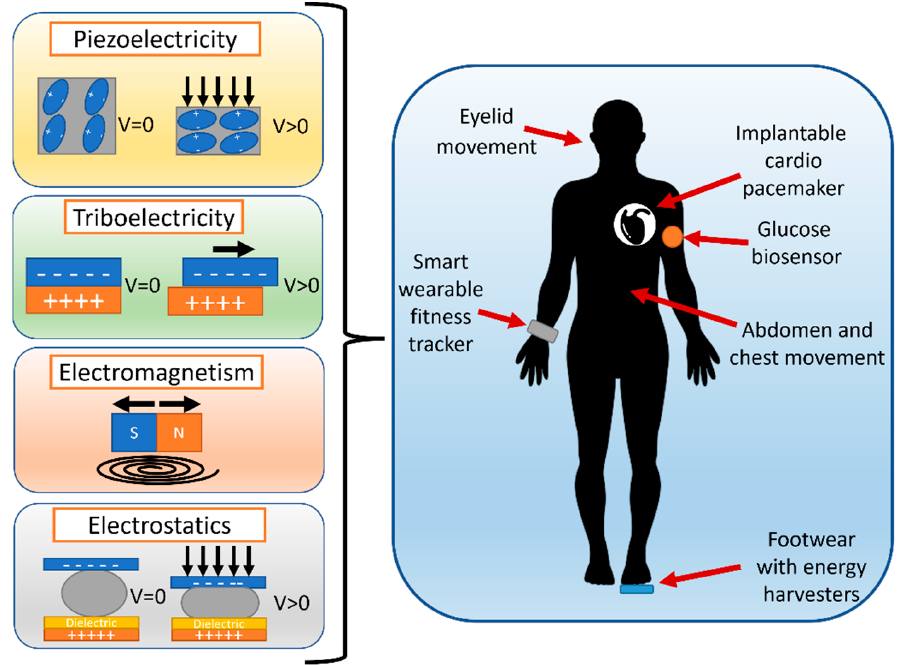
Figure 6. Biomechanical energy in the human body [54].